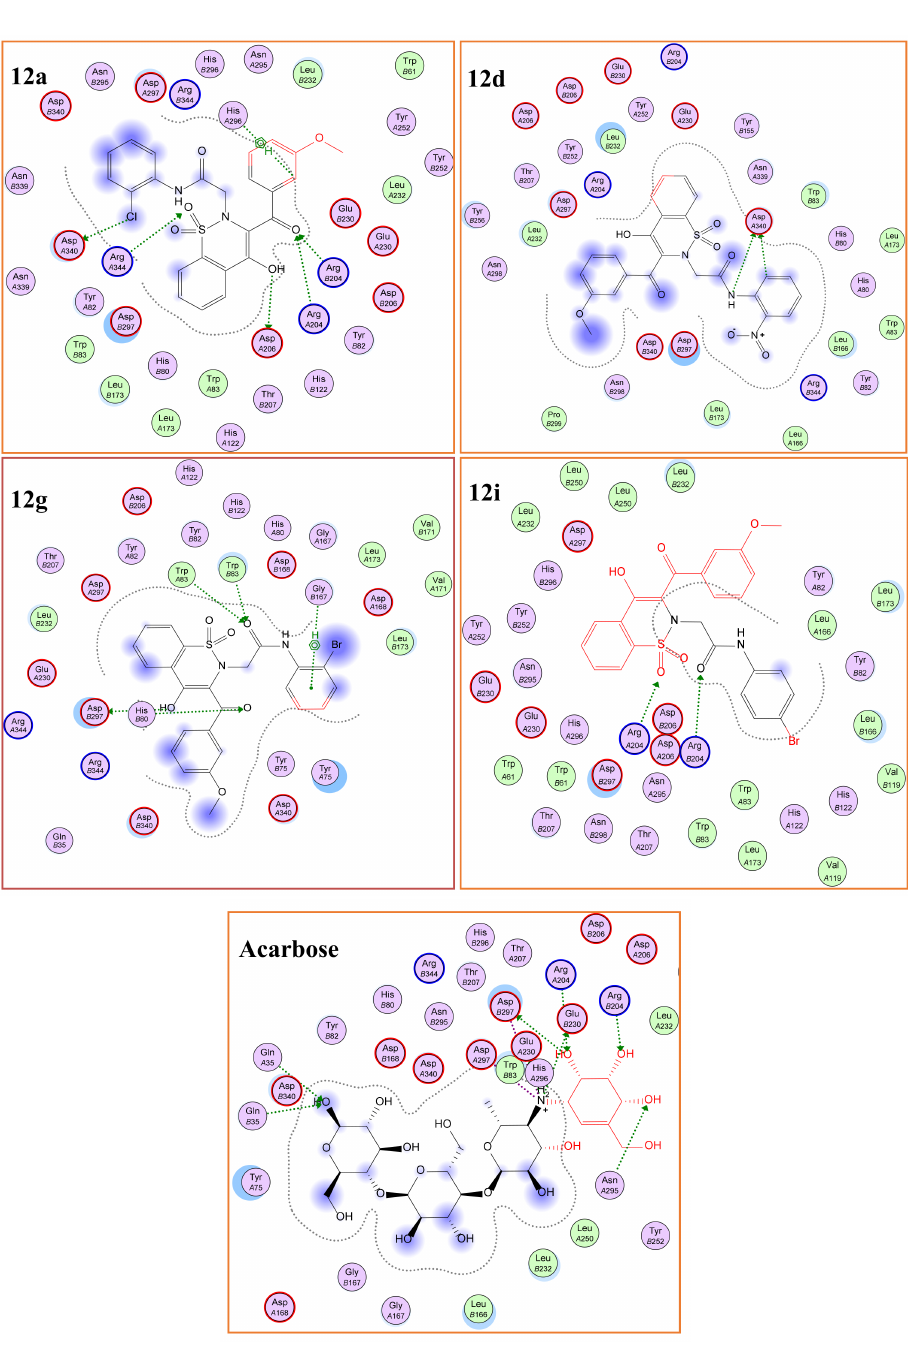
Figure 3. Binding interactions (2D maps) of potent compounds ( 12a , 12d , 12g , 12i ) and the refer- ence drug, acarbose, against α -amylase enzyme. Ligand exposure points are indicated with blue color, while the binding interactions of ligands with the receptor enzyme are indicated with green dotted